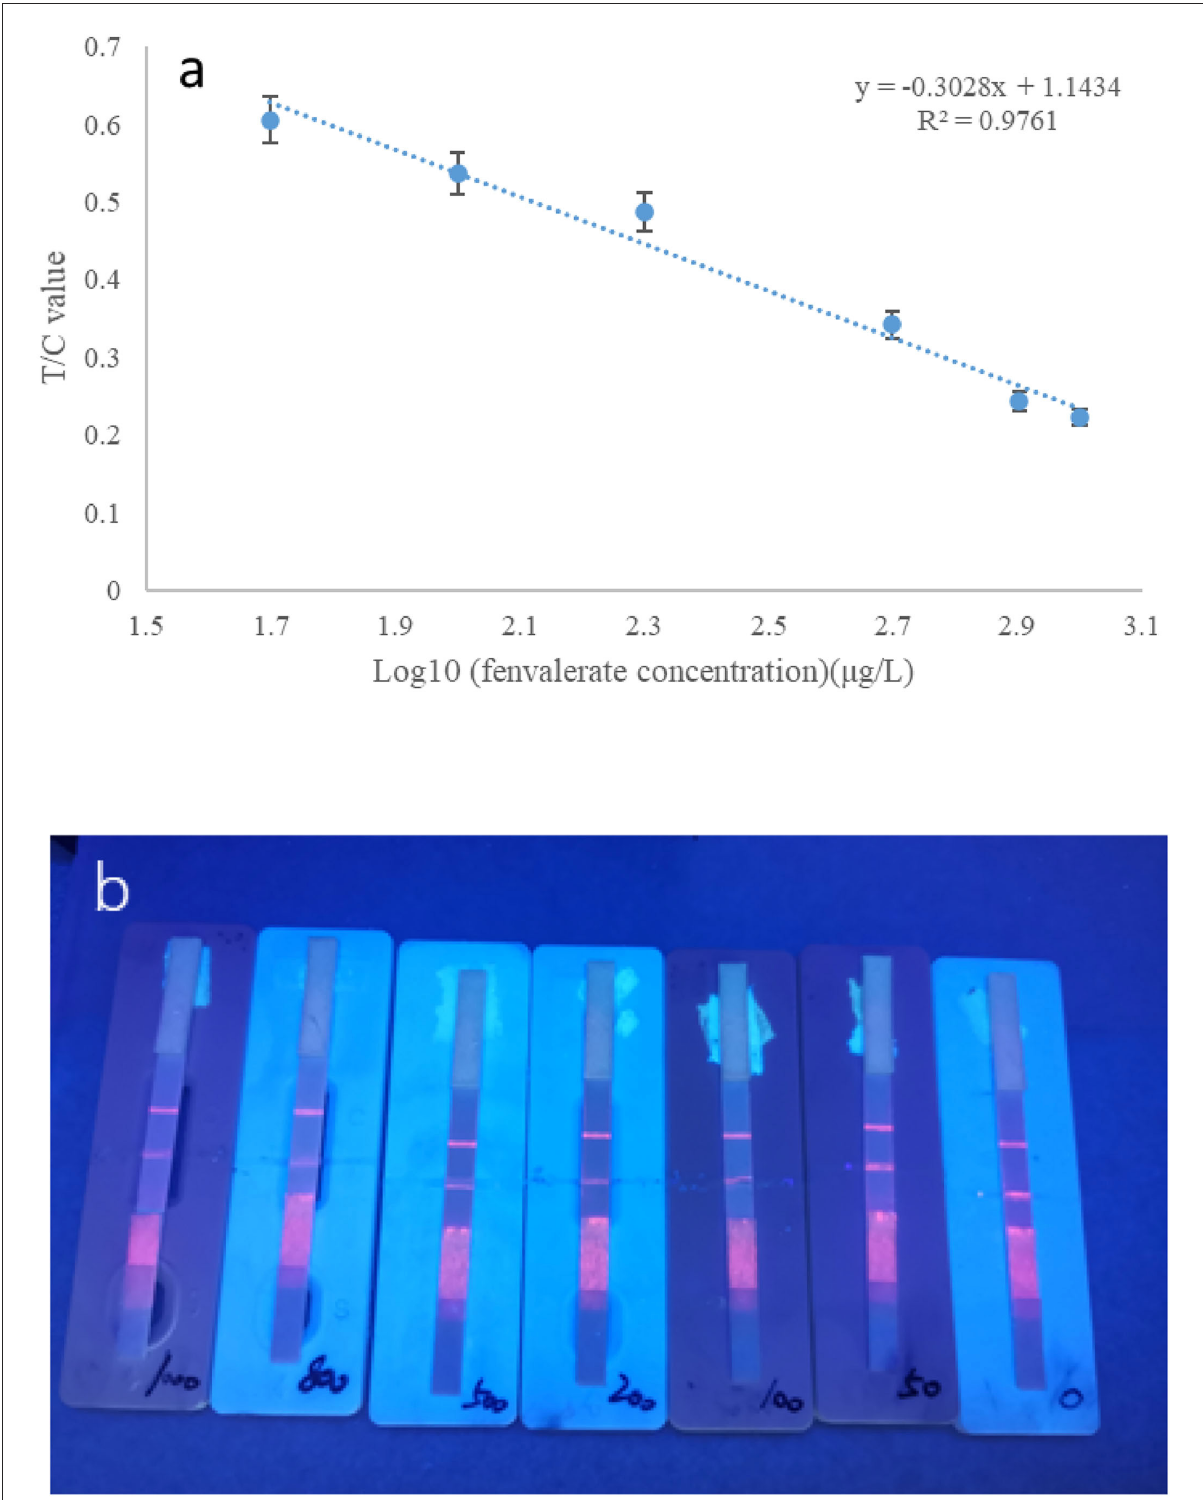
FIGURE8 (a) Standard curve of fenvalerate measured by strip. (b) Different concentrations of fenvalerate (from right to left 0, 50, 100, 200, 500, 800, and 1,000 µ